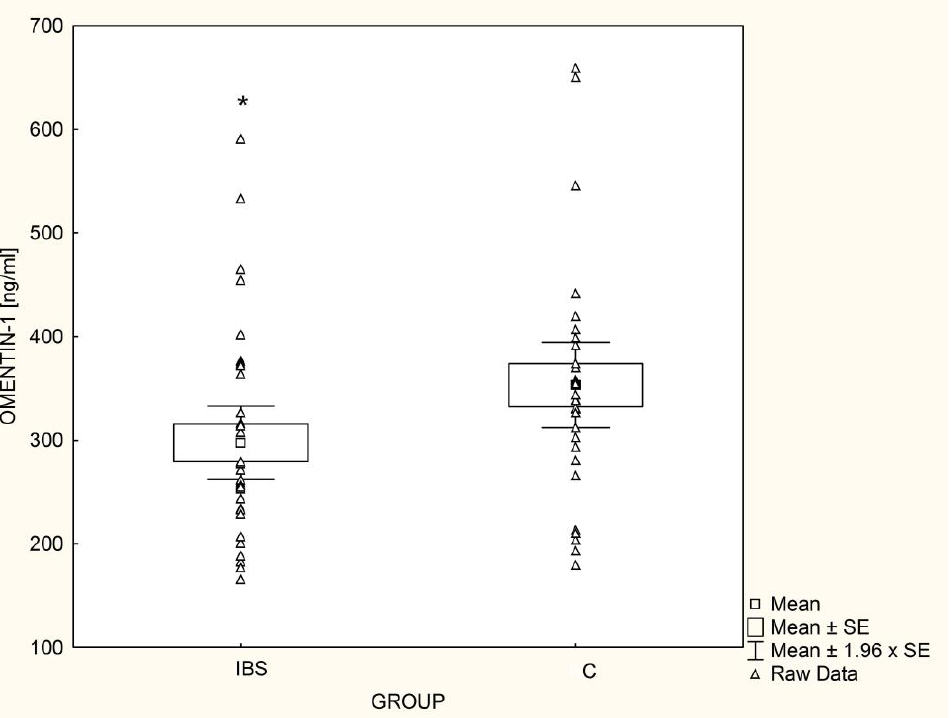
Figure 4. Mean omentin-1 levels in children with irritable bowel syndrome (IBS; n = 33) and controls (C; n = 30), * p = 0.04.